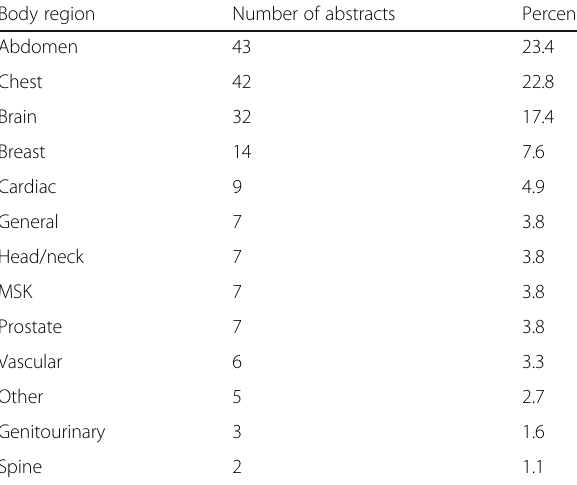
Table 2 Distribution of abstracts from participating countries